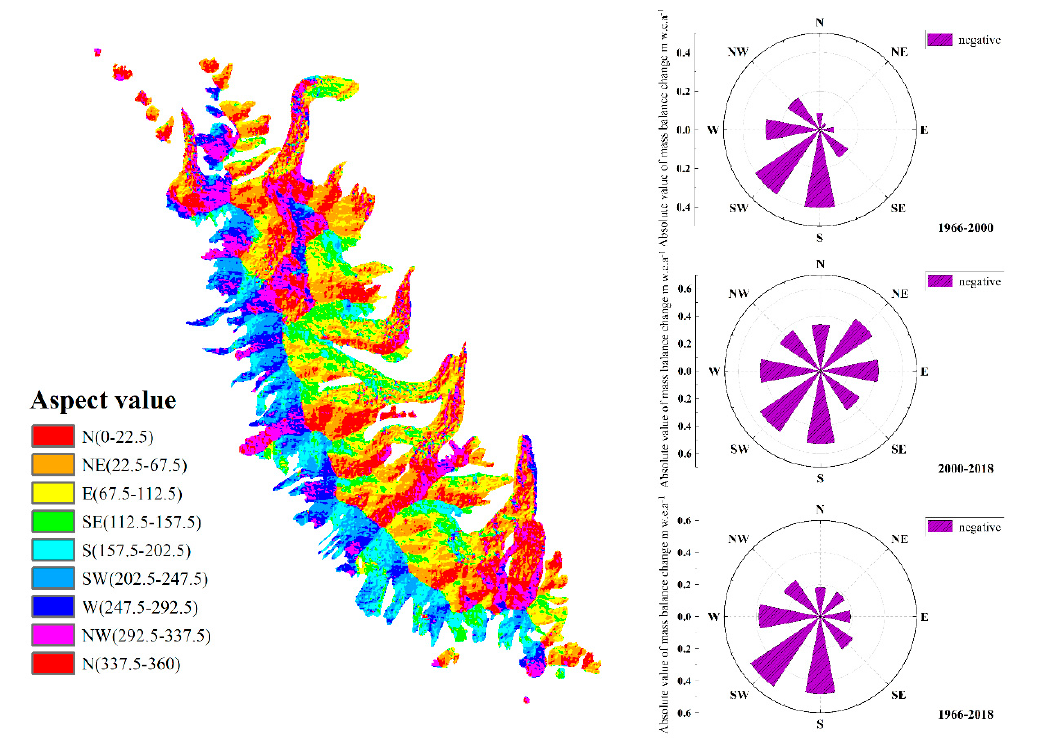
Figure 6. Map of the glacier aspect and the changes in mass balance in different aspects for the 1966– 2000, 2000–2018, and 1966–2018 periods. 1966–2000, 2000–2018, and 1966–2018